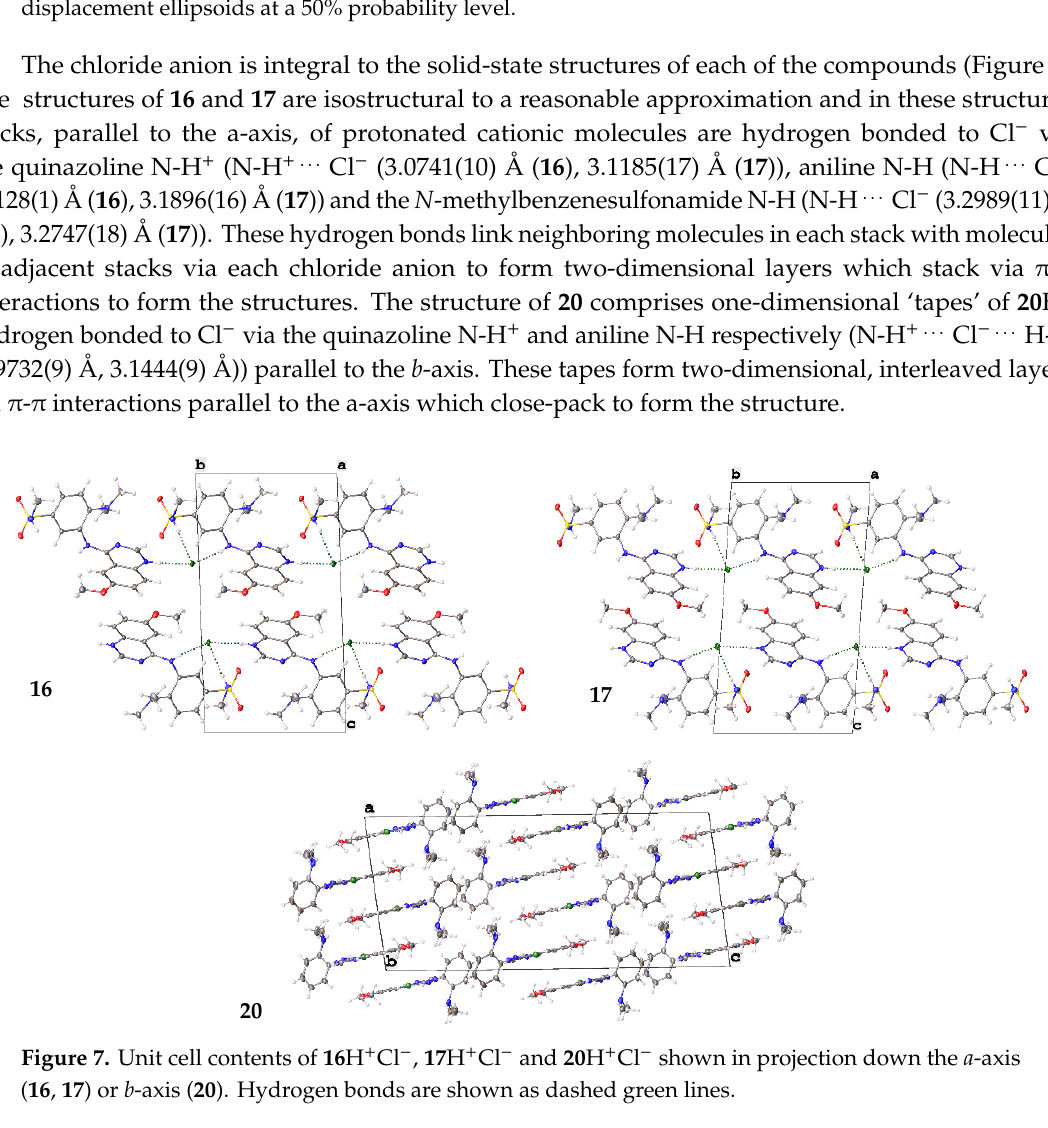
Figure 6. Molecular structure of 16 H + Cl − , 17 H + Cl − and 20 H + Cl − showing atomic labeling and displacement ellipsoids at a 50% probability level.